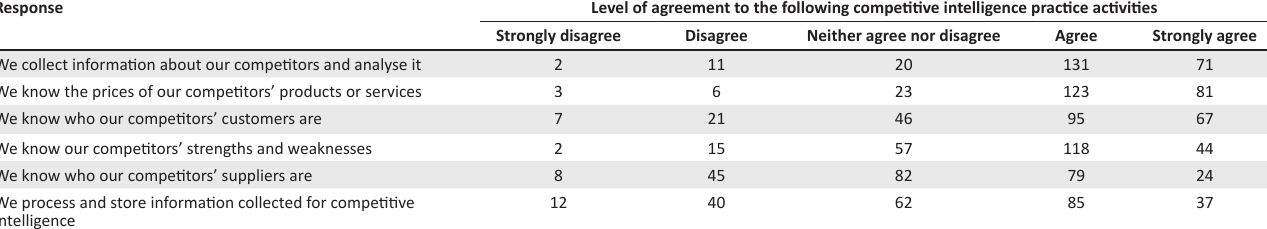
TABLE 12: Frequency of responses to competitive intelligence practice activities in the property sector ( N = 239). Response